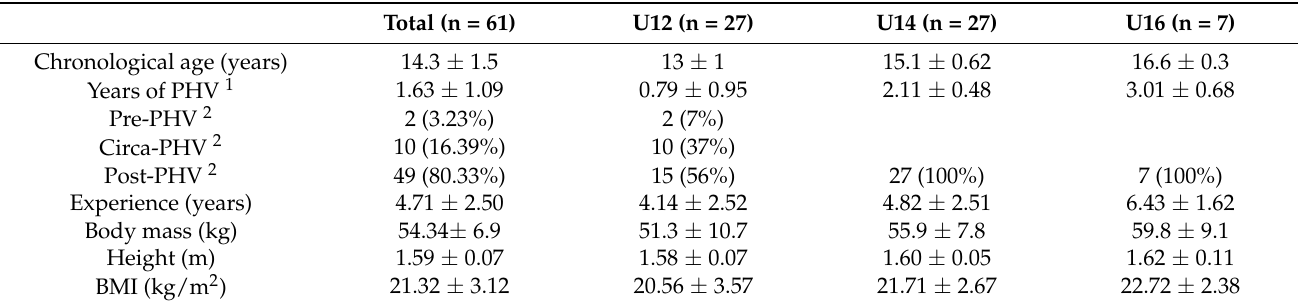
Table 1. Descriptive data of the participants (mean ± standard